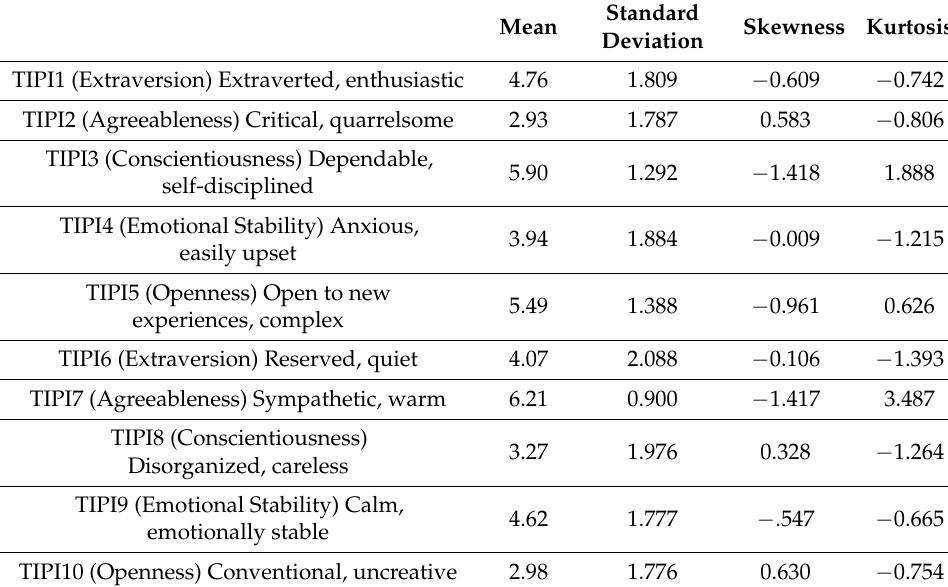
Table 2. Descriptive statistics for the items on the Ten Item Personality Inventory